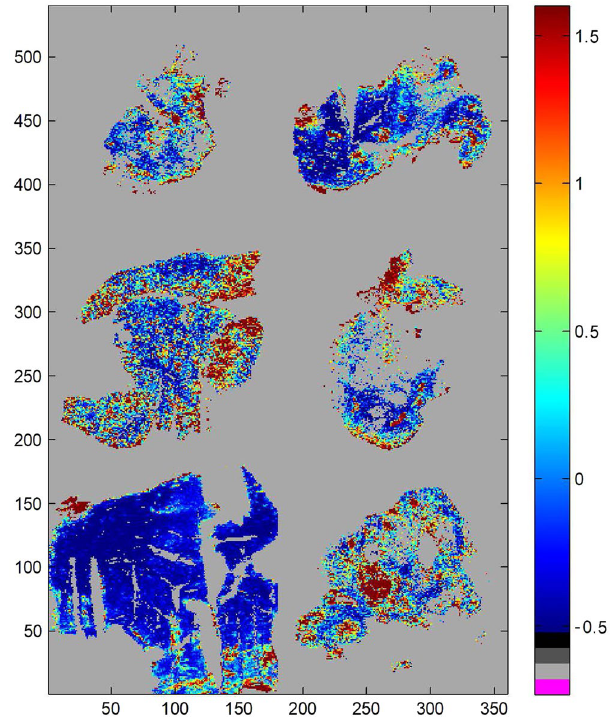
for both 13 C and 64 Zn.